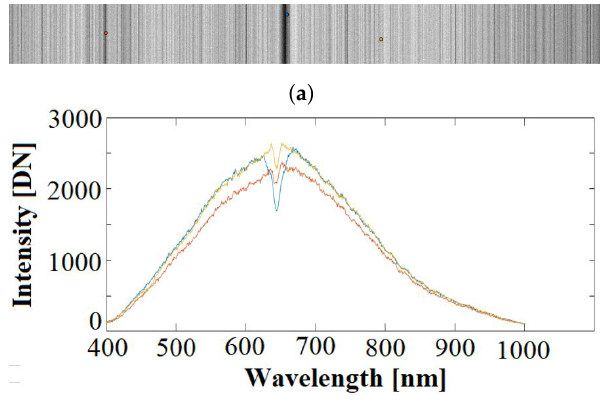
Figure 3. Example WR image for light source calibration: ( a ) Band number 319 (361 nm) where three pixels have been marked in red, blue and yellow. ( b ) Spectral signatures of the three marked pixels (Intensity is presented in sensor